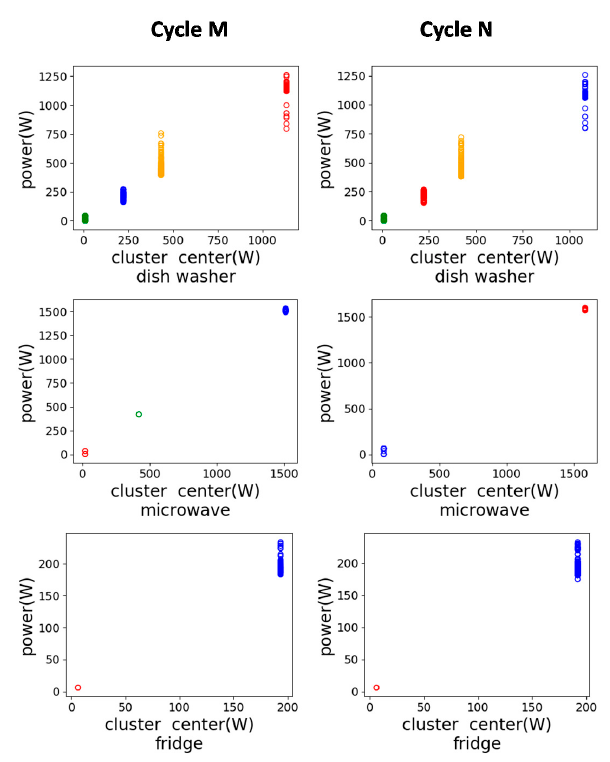
Figure 4. State diagrams of different appliances.